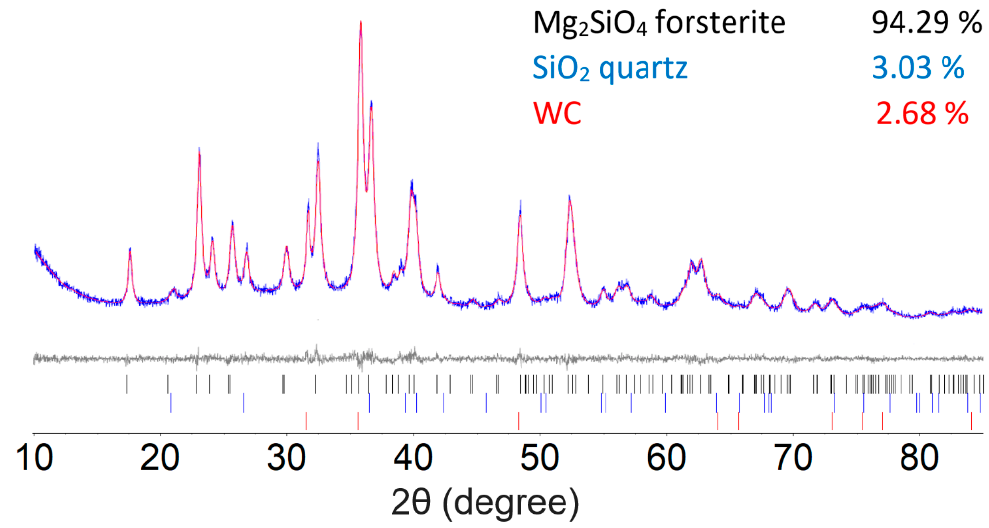
Figure 1. The Rietveld refinement of the 2:1 molar ratio of MgO and SiO 2 after 180 min of milling time. The bottom curve shows the difference between the observed and the calculated intensities. Tick marks below indicate the peak positions for Mg 2 SiO 4 , unreacted SiO 2, and WC.